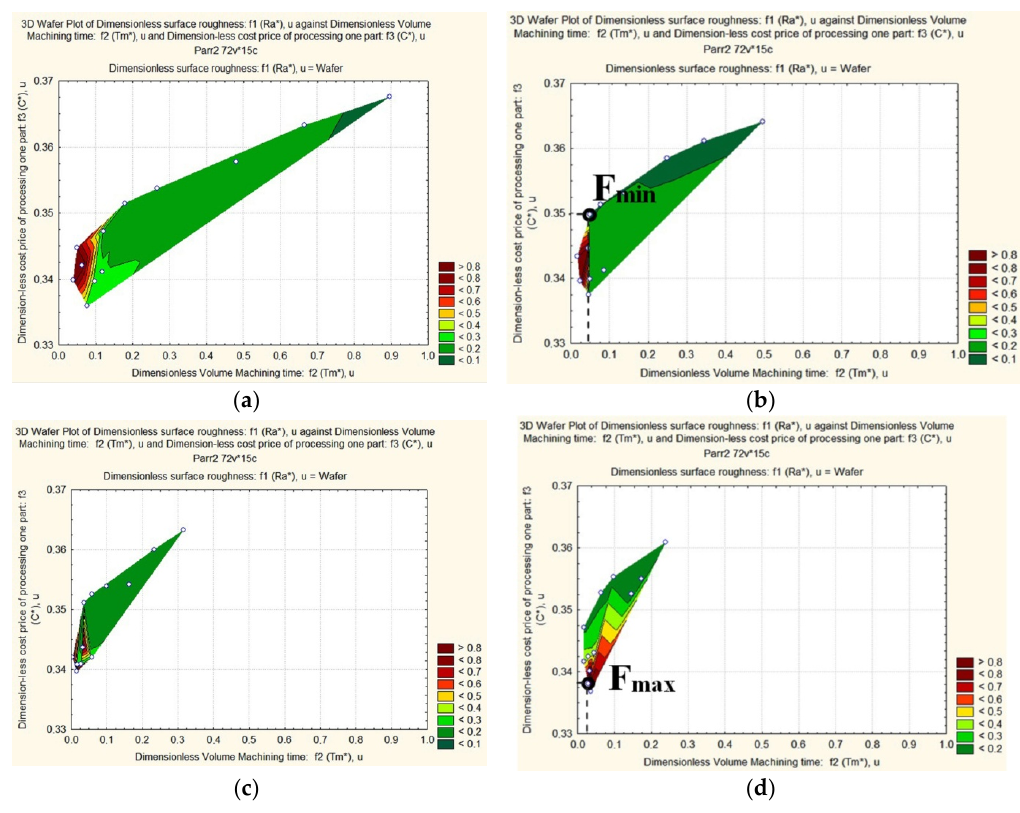
Figure 8. Surface projections of Ra * values depending on the change in the values of С * and T m * at a fixed depth of cut (the case of obtaining an AA6061 alloy workpiece with ET-500 extrusion):